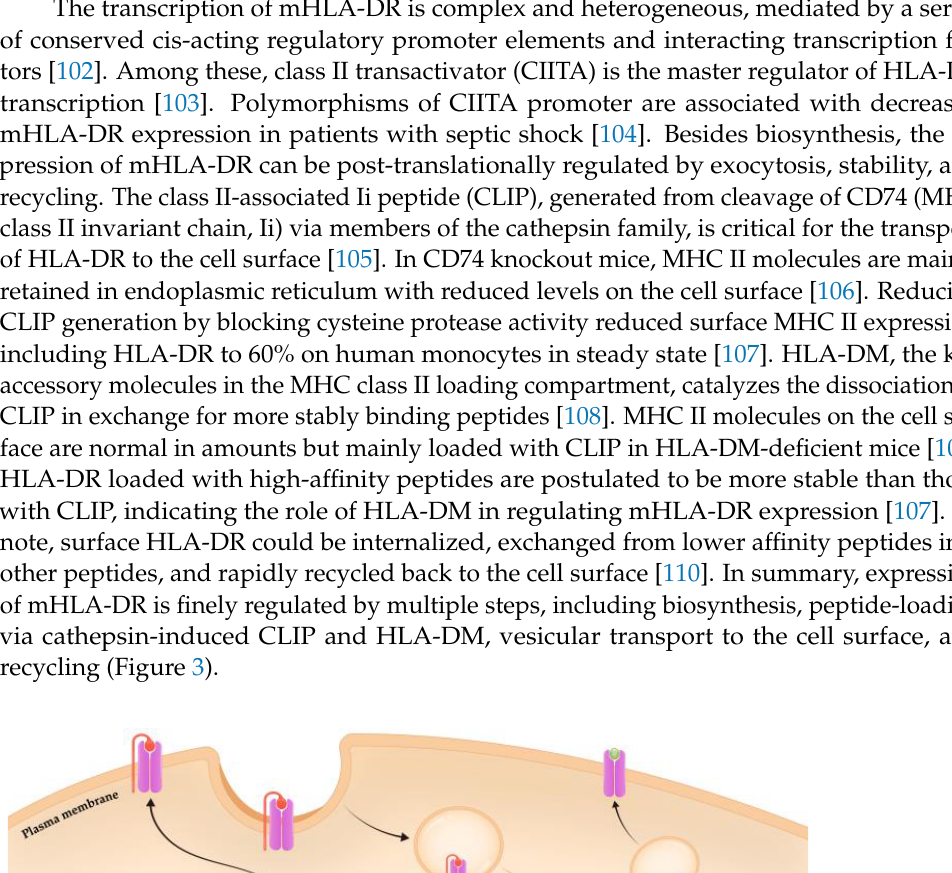
6 of 21 Figure 2. Measurement of mHLA-DR expression. ( A ) Measurement of mHLA-DR expression and requirements for sample handling procedures [97 – 101]. ( B ) Relationship of units of mHLA-DR ex-